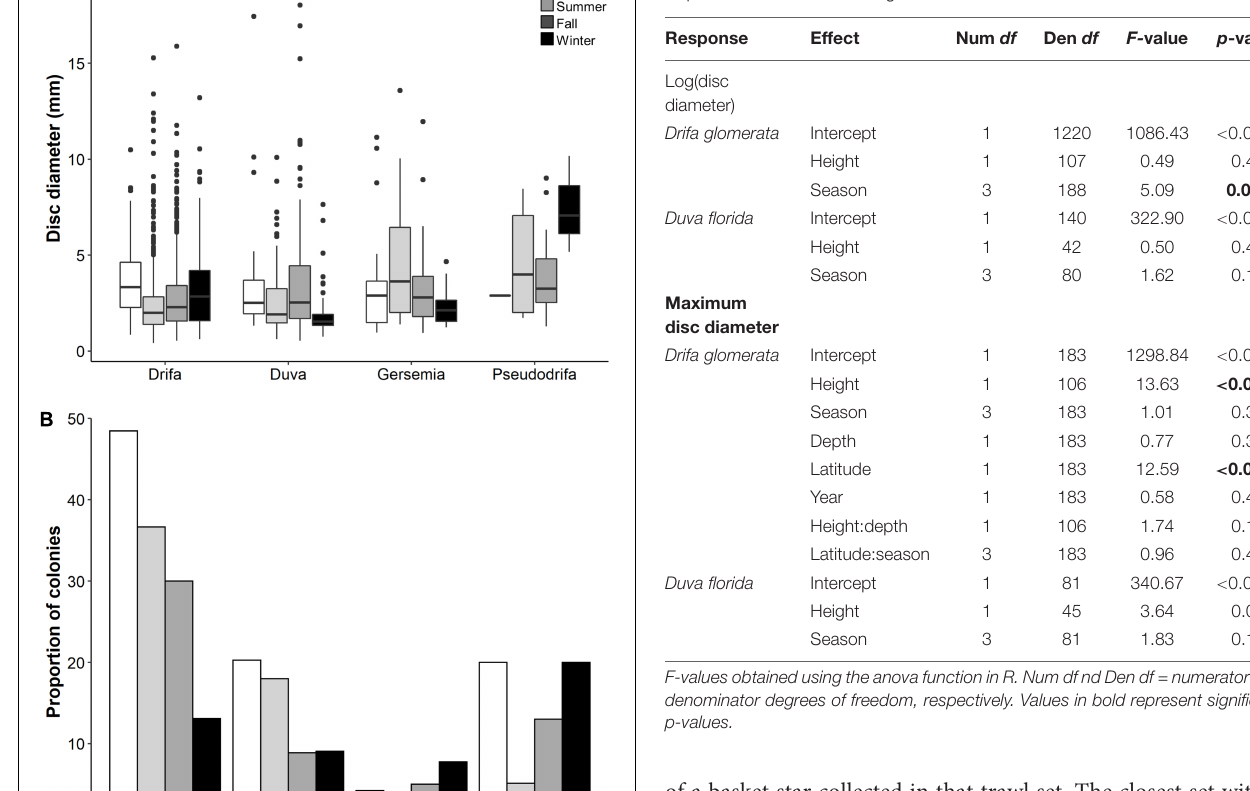
When examining the DFO-RV database pooled (2011–2017, Figure 9 ), 45% of trawl sets containing basket stars ( N = 2624) also had corals ( N = 1186), of which 67% were Nephtheidae soft corals only ( N = 796), followed by a mix of coral taxa that could also include soft corals (16%). The total percentage of trawl